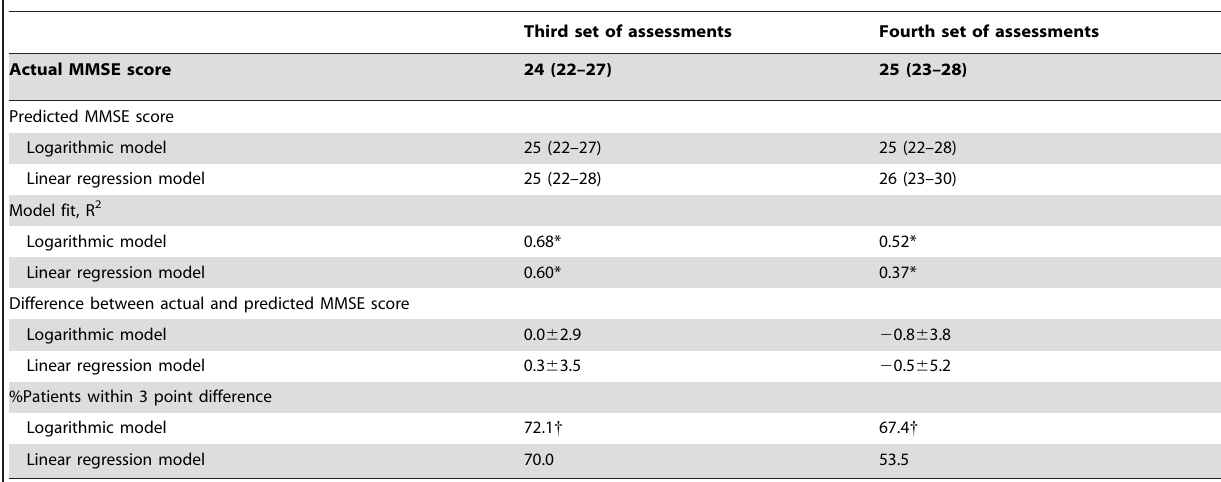
Table 2. Profile of Recovery on Mini-Mental State